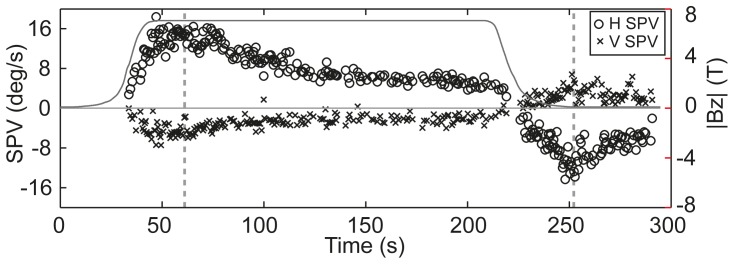
Nystagmus slow phase velocity.Horizontal (circles; Positive = leftward/+Z ocular rotation) and vertical (crosses, Positive =  downward/+Y ocular rotation) slow phase velocity (SPV; left axis) plotted over the magnitude of the Z magnetic field (BZ; grey; right axis) during a trial in experiment 2. The vertical lines indicate times at which the bed stops moving following entry into the magnet and stops moving following exit from the magnet.